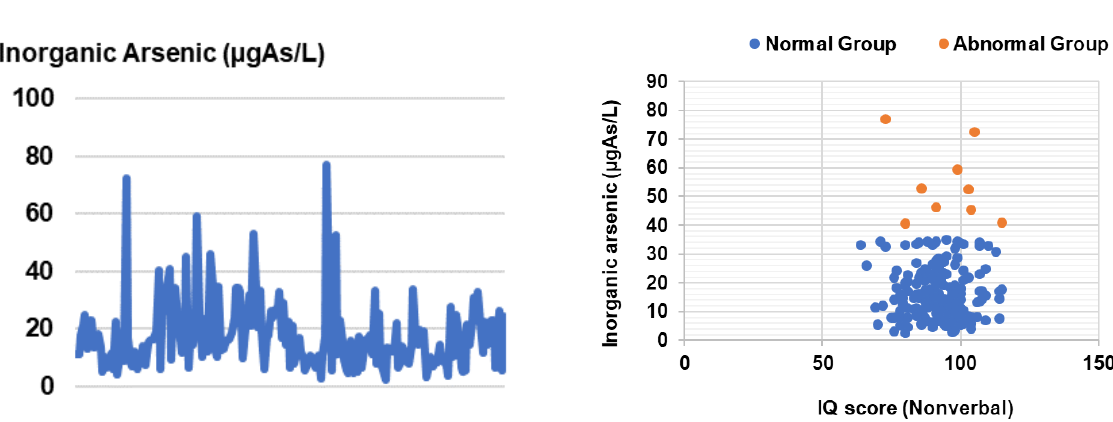
Figure 2: Scatter plot of inorganic arsenic